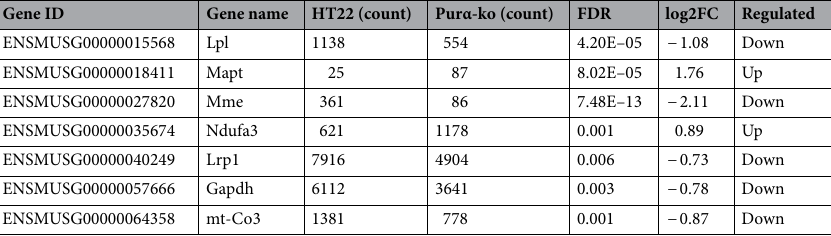
Table 2. Differential gene enriched in Alzheimer’s disease.